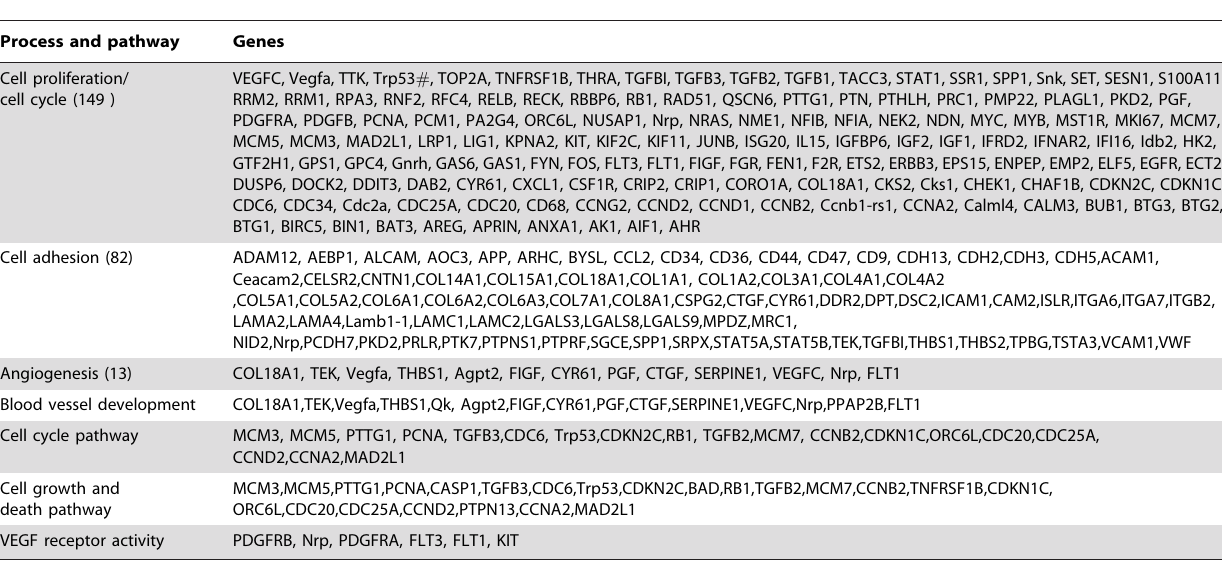
Table 1. The enrichment of ontology in 835 intrinsic